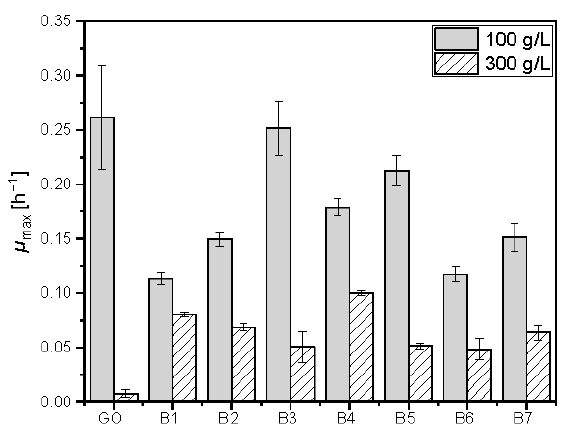
Figure 4. Maximal growth rates ( µ max ) of Bombella strains and Gluconobacter oxydans DSM46615 (GO) at 100 and 300 g L − 1 glucose at 30 °C. B1: B. favorum TMW 2.1880; B2: B. apis TMW 2.1882; B3: B. apis TMW 2.1884; B4: B. apis TMW 2.1886; B5: B. apis TMW 2.1888; B6: B. apis TMW 2.1890; B7: B. apis TMW 2.1891.